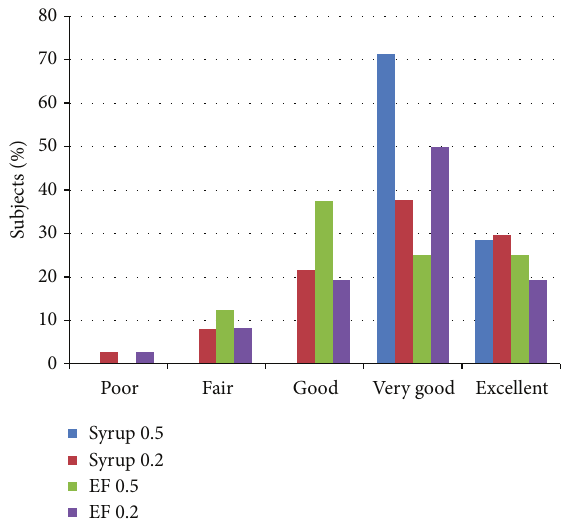
Figure 5: Percentage of subjects in each of Houpt categories of overall behavior in two study groups adjusted for age/dose (dose 0.5 or 0.2